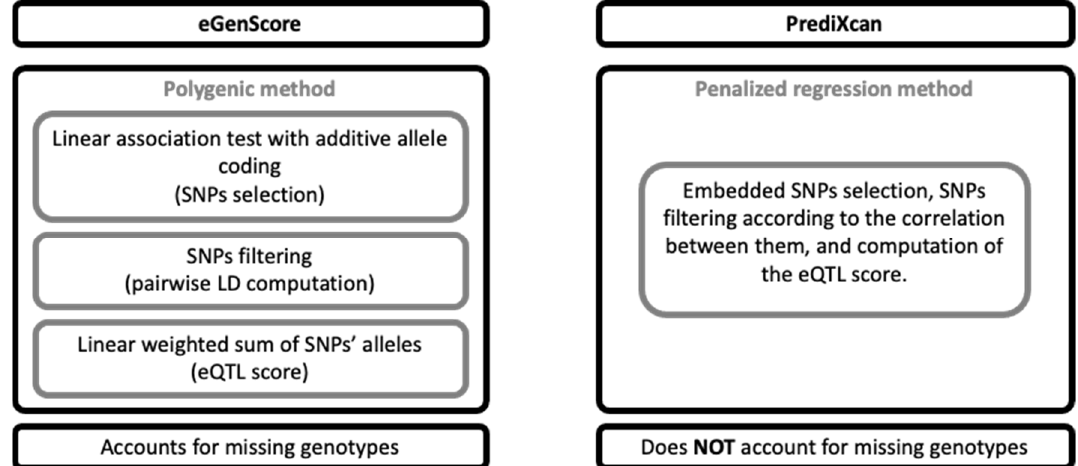
Figure 2. Comparison of the eGenScore’s and PrediXcan’s methodological features. LD: linkage disequilibrium; SNP: single nucleotide polymorphism.